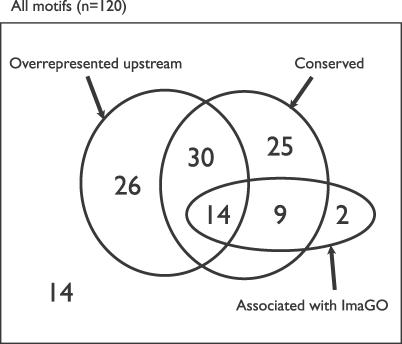
Summary of Lines of Evidence Supporting 120 Motifs Discovered in This Study